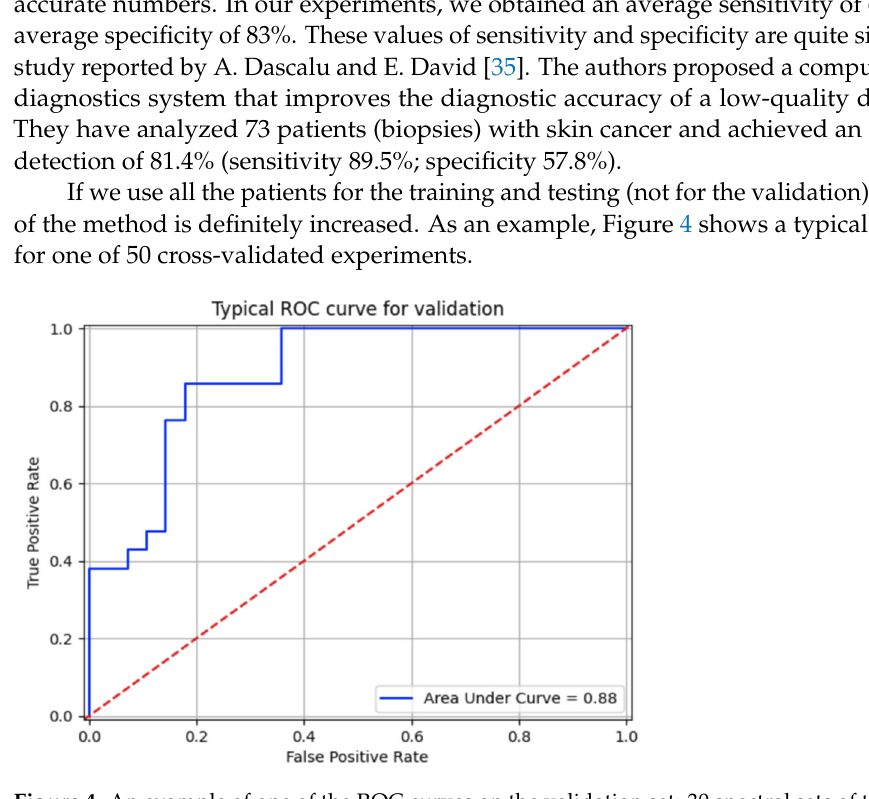
Figure 4. An example of one of the ROC curves on the validation set: 30 spectral sets of the validation set (seven patients, 10 cases). The area under the curve (AUC) is 0.88.